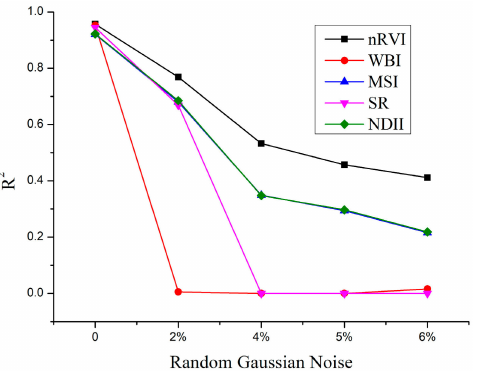
Figure 10. Accuracy of nRVI, WBI, MSI, SR, and NDII for EWT estimation across various spectral noise based on synthetic datasets with various random Gaussian noise.